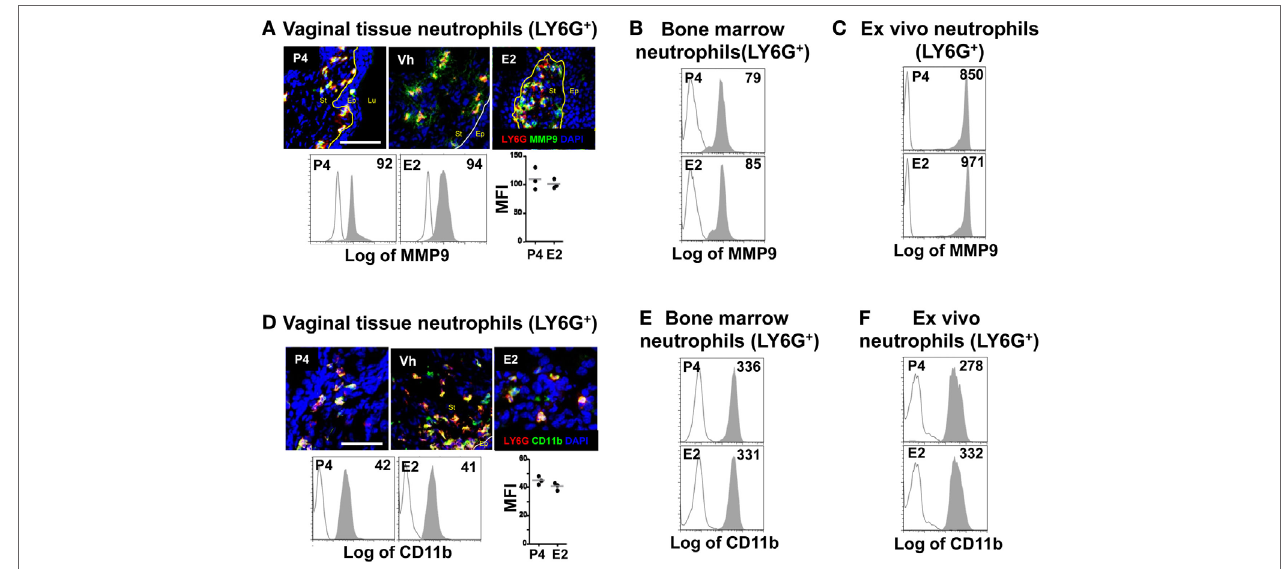
FigUre 3 | Hormone-treated ovariectomized mice were mock or Candida albicans inoculated in the vagina. (a) Representative pictures of sections assayed for metallomatrix proteinase 9 (MMP9) (green) and LY6G + (red). Representative flow cytometry plots and quantification of the MMP9 expression in LY6G + neutrophils from the lower female reproductive tract (FRT) of hormone-treated mice. MMP9 expression in LY6G + neutrophils from in vivo hormone treated mice, (B) bone marrow, and (c) ex vivo treated neutrophils. (D) Representative pictures of sections assayed for CD11b (green) and LY6G + (red). Representative flow cytometry plots and quantifications of the lower FRT neutrophils from hormone-treated mice. CD11b expression in LY6G + neutrophils from in vivo hormone treated mice, (e) bone marrow, and (F) ex vivo treated neutrophils. Isotype control mAb (line) and indicated mAb (gray filled lines). Scale bar, 50 µm. Each circle represents a mouse in (a,D) , n = 4 in (B,e) and n = 5 in (c,F) . Abbreviations: E2, estradiol; Vh, vehicle; P4, progesterone; Lu, lumen; Ep, epithelium; St,